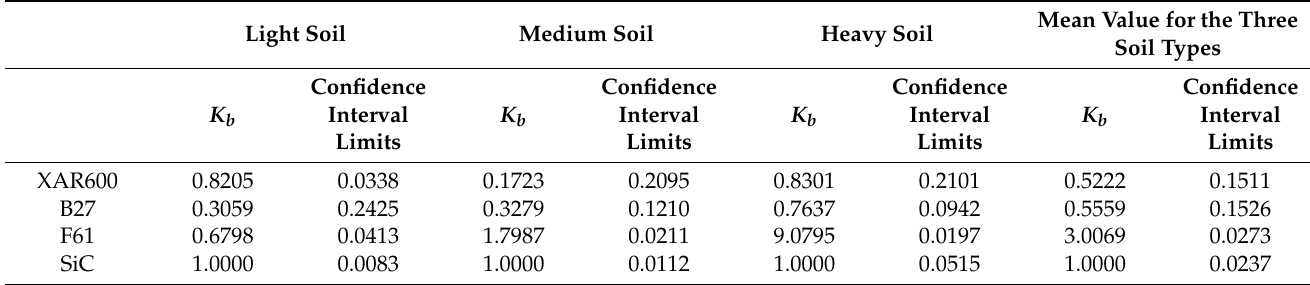
Table 6. Abrasive wear index K b